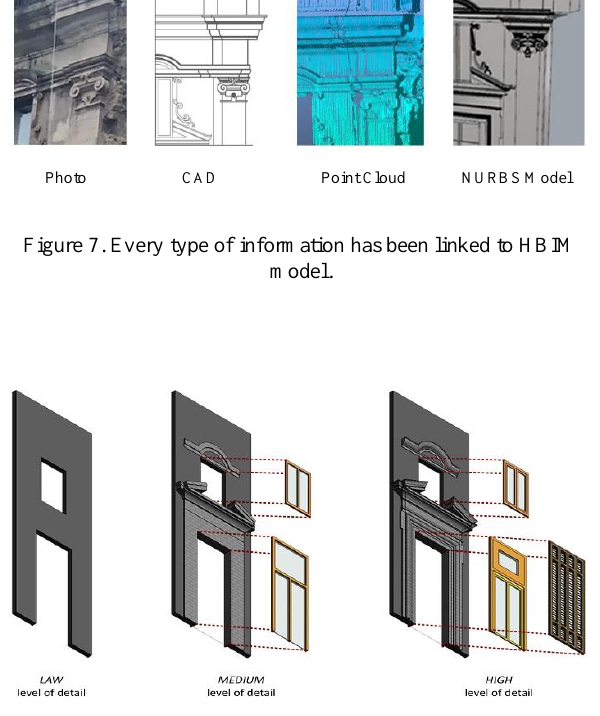
Figure 8. The window with the tympanum has been modelled with different level of detail evaluating different possible